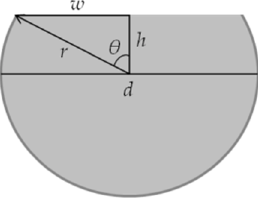
Figure 2. Image of a D-shaped fiber, where d is the fiber diameter, r the radius, h the depth, and w the half width of the sensing region.